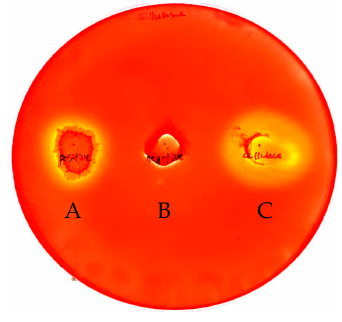
Figure 2. Congo-red staining assay of wild-type B. licheniformis ( A ); non-cellulase producing E. coli ( B ); and recombinant E. coli harboring INP-cellulase genes ( C ); all of which were topped and cultivated on agar medium of 0.5% CMC at 30 °C for 18 h. The hollow clear zones around the colonies indicate the degradation of CMC as a result of the cellulolytic enzymes.